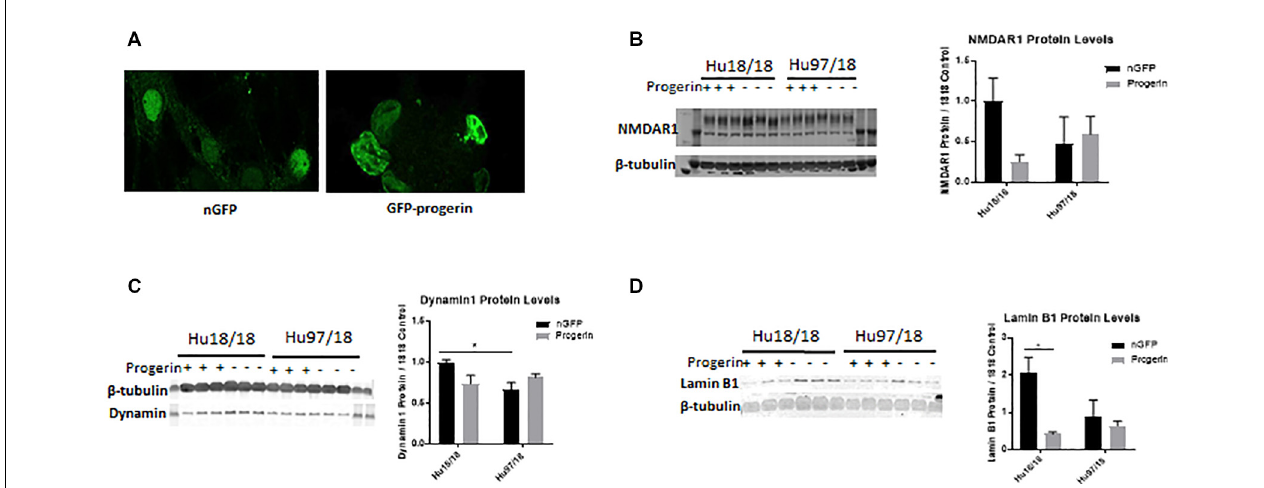
FIGURE 4 | Progerin treatment induces aging in primary neurons. Mature primary Hu18/18 and Hu97/18 neurons were treated with nGFP or progerin. (A) Progerin induces nuclear blebbing, which occurs with age. (B–D) WB analysis of proteins known to decrease over natural aging; (B) NMDAR1, (C) Dynamin1, and (D) lamin B1. *Difference between indicated bars, * p < 0.05. Error bars ± SEM.